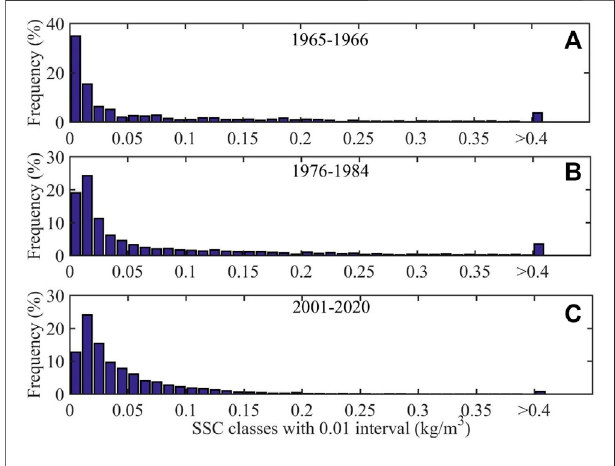
FIGURE 7 | Frequency of the daily SSC at the three stages (A) 1965 – 1966; (B) 1976 – 1984; (C) 2001 –